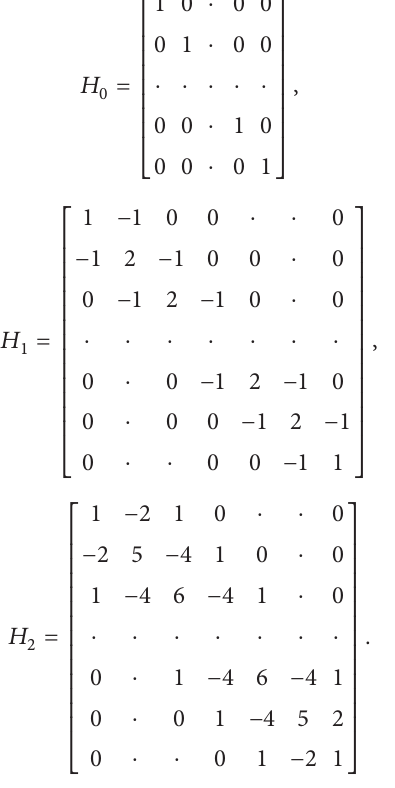
Figure 3: Comparison of the original 𝑥 value of the particle size distribution for the NNLS approach in dependency on the discretization of the particle size